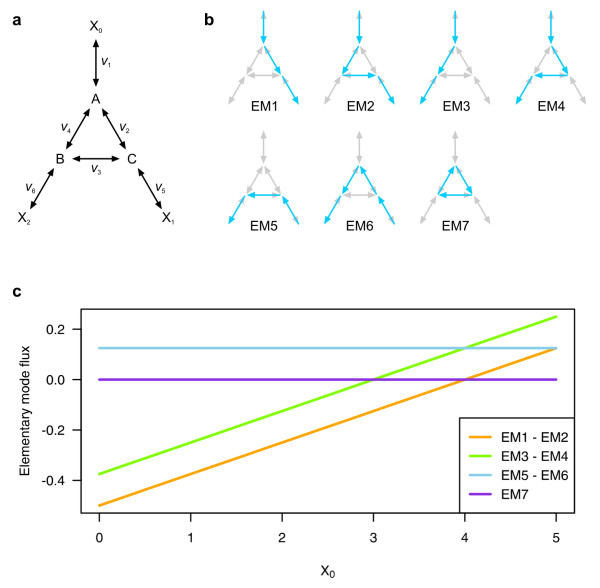
Theoretical example. a. Theoretical model presented by [29]. All reactions were modelled as having reversible mass-action kinetics with rate constants equal to one. b. The seven elementary modes of the system, taking X0, X1 and X2 as external metabolites. Since all reactions in the system are reversible, all elementary modes are reversible as well. The direction of blue arrows therefore only refers to a conventional positive direction for elementary mode fluxes; a negative elementary mode flux means that the mode is running in the opposite direction. c. Variations of elementary mode fluxes for concentrations of X0 ranging from 0 to 5, while X1 and X2 have constant concentrations of 4 and 3 respectively.